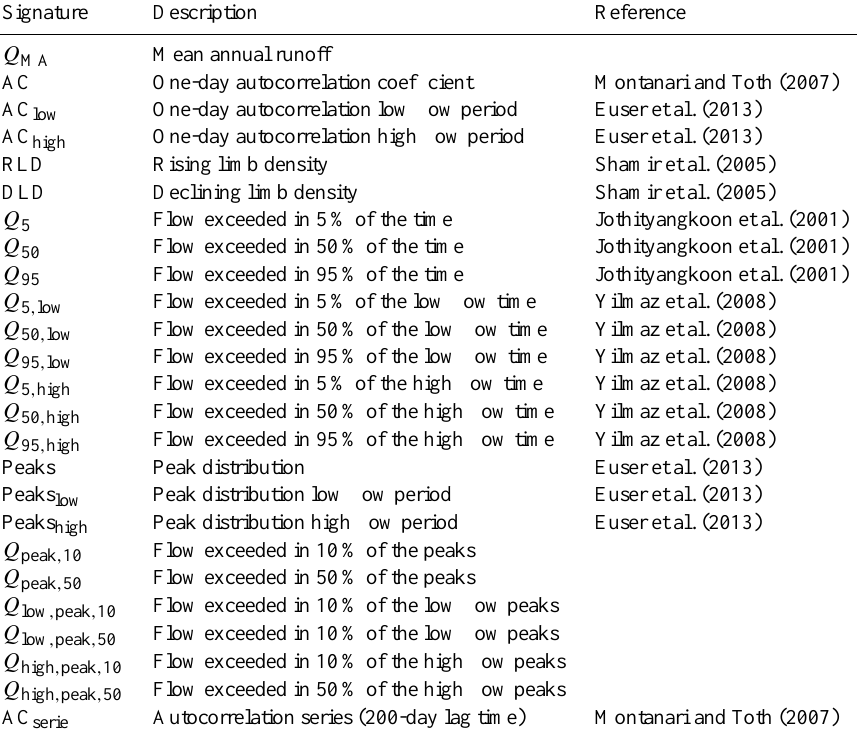
Table 3. Overview of the used